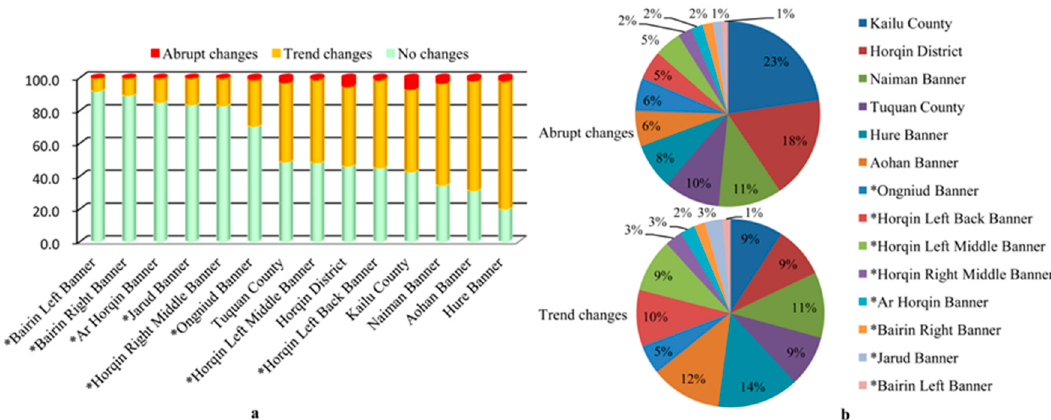
Figure 7. Change detection results in different banners (counties or cities): ( a ) percentages of different change types; and ( b ) percentages of abrupt changes and trend changes. * Banners (counties or cities) of pastoral area in Figure 1.